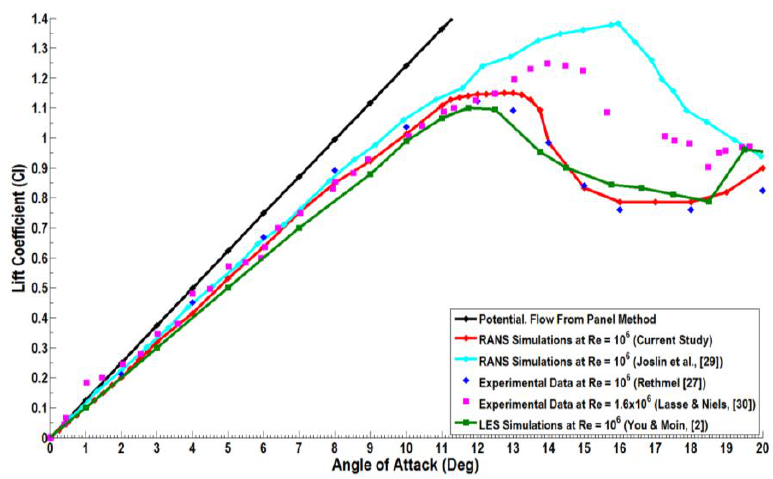
Figure 10. Comparison of lift coefficient C l values of the airfoil at 0° flap deflection as a function of (α) at chord Re = 10 6 with experimental and numerical results.